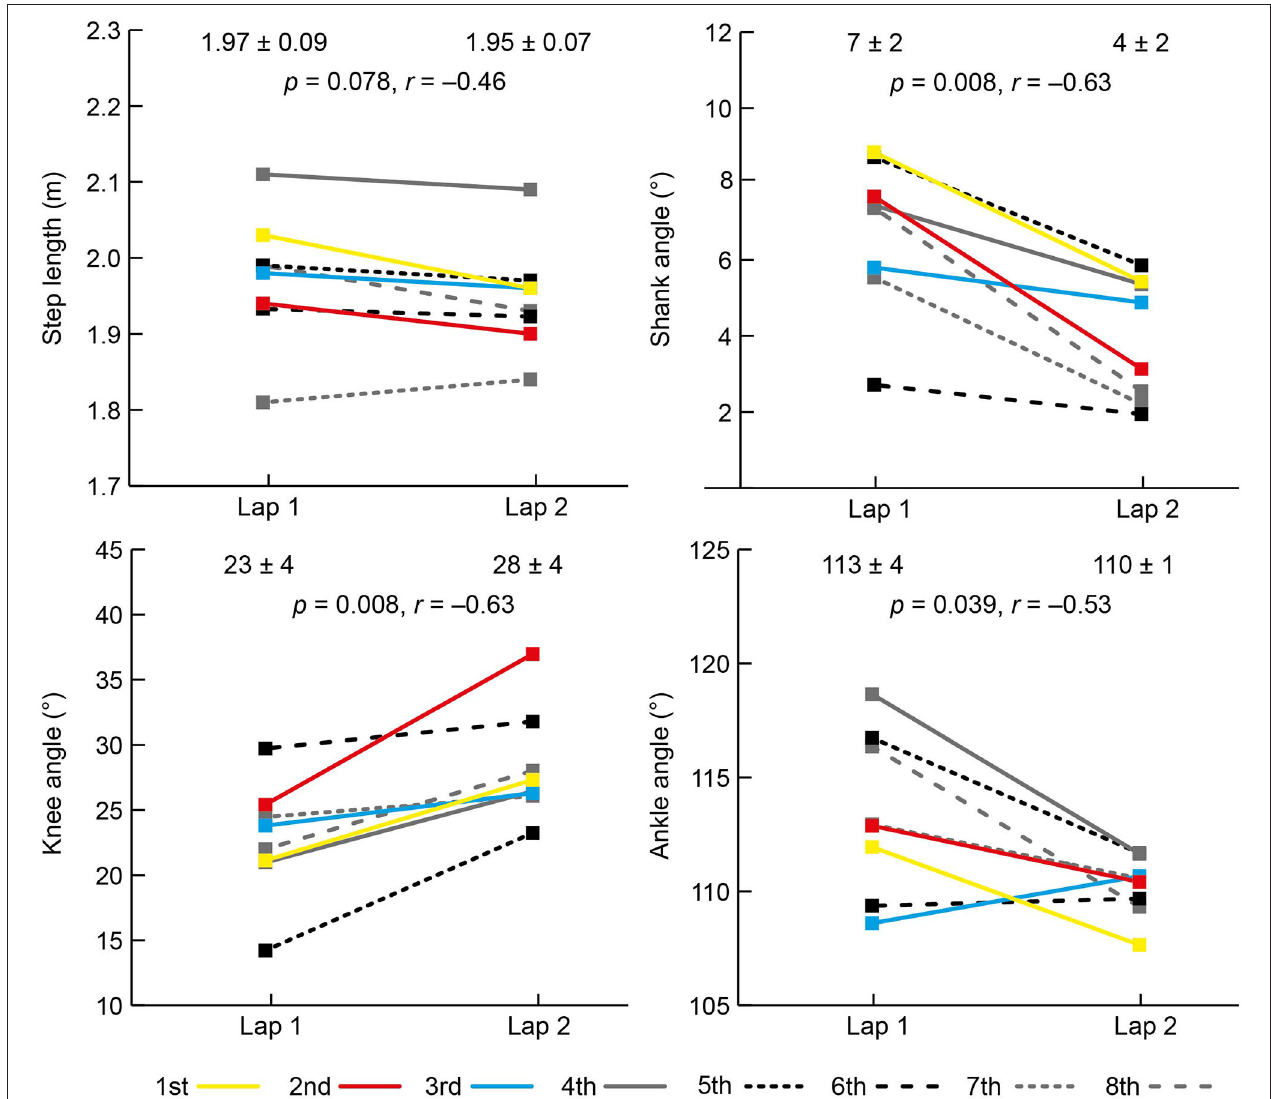
FIGURE 3 | Mean ( ± SD) and individual athlete data for spatial and angular data on laps 1 and 2 of the women’s 800m final. The color used to represent each athlete is the same for each variable and the key for finishing positions is shown at the bottom of the